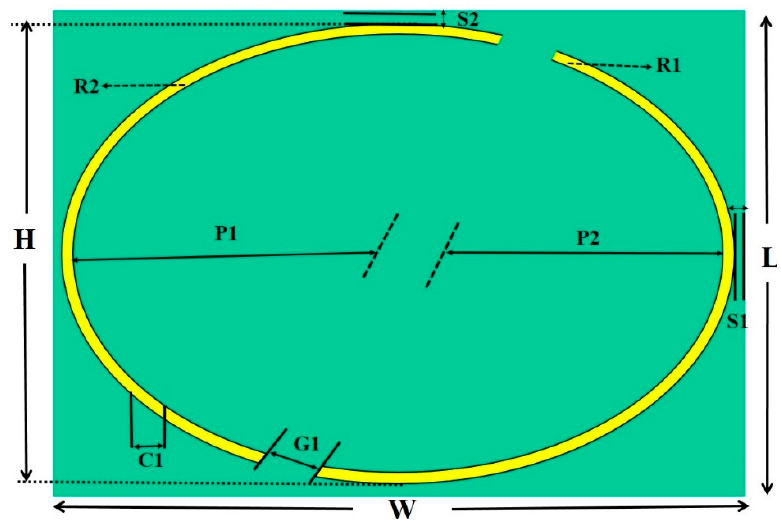
Figure 3. Dual resonant element geometric design.